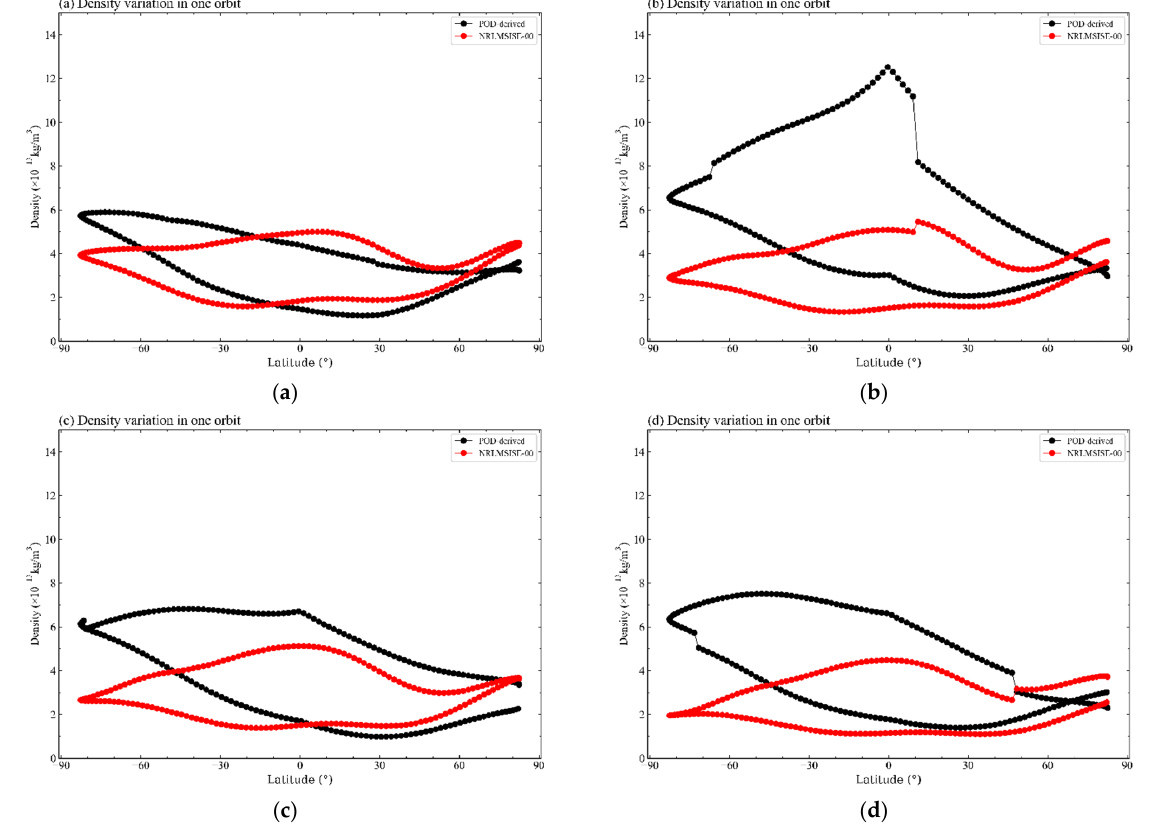
Figure 8. The density variation during one orbital period. ( a – d ) Description of the density variations on 4 November 2021. The image order is the chronological order of the exact day. ( a ) The orbital density before the geomagnetic storm. ( b ) The main phase of the QQ-Satellite experiencing a geomagnetic storm of a lap of orbit. ( c , d ) The recovery phases. The upper part of the orbital arc is the descending orbit at dusk (near 18:00 local time), and the lower part of the orbital arc is the ascending orbit at dawn (near 06:00 local time).